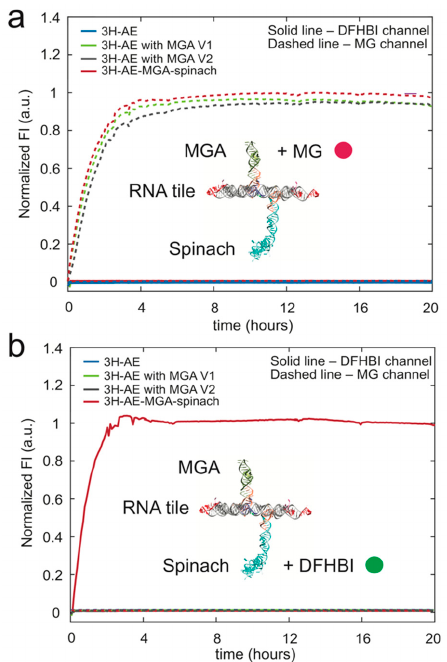
Figure 4. Monitoring transcription of RNA tiles via aptamer fluorescence. MG and the Spinach aptamer fluorophore 3,5-difluoro-4-hydroxybenzylidene imidazolinone (DFHBI) were added to transcription reactions of all four versions of RNA tiles. The structure of the 3H-AE-MG-Spinach-KL RNA tile is shown as an inset to the figures: ( a ) MGA and ( b ) Spinach (DFHBI) fluorescence recorded during transcription of the various RNA tiles constructed (Ex = 615–645 nm, Em = 669–699 nm for MG and Ex = 475–495 nm, Em = 515–545 nm for DFHBI; fluorescence intensities normalized with respect to maximum fluorescence).